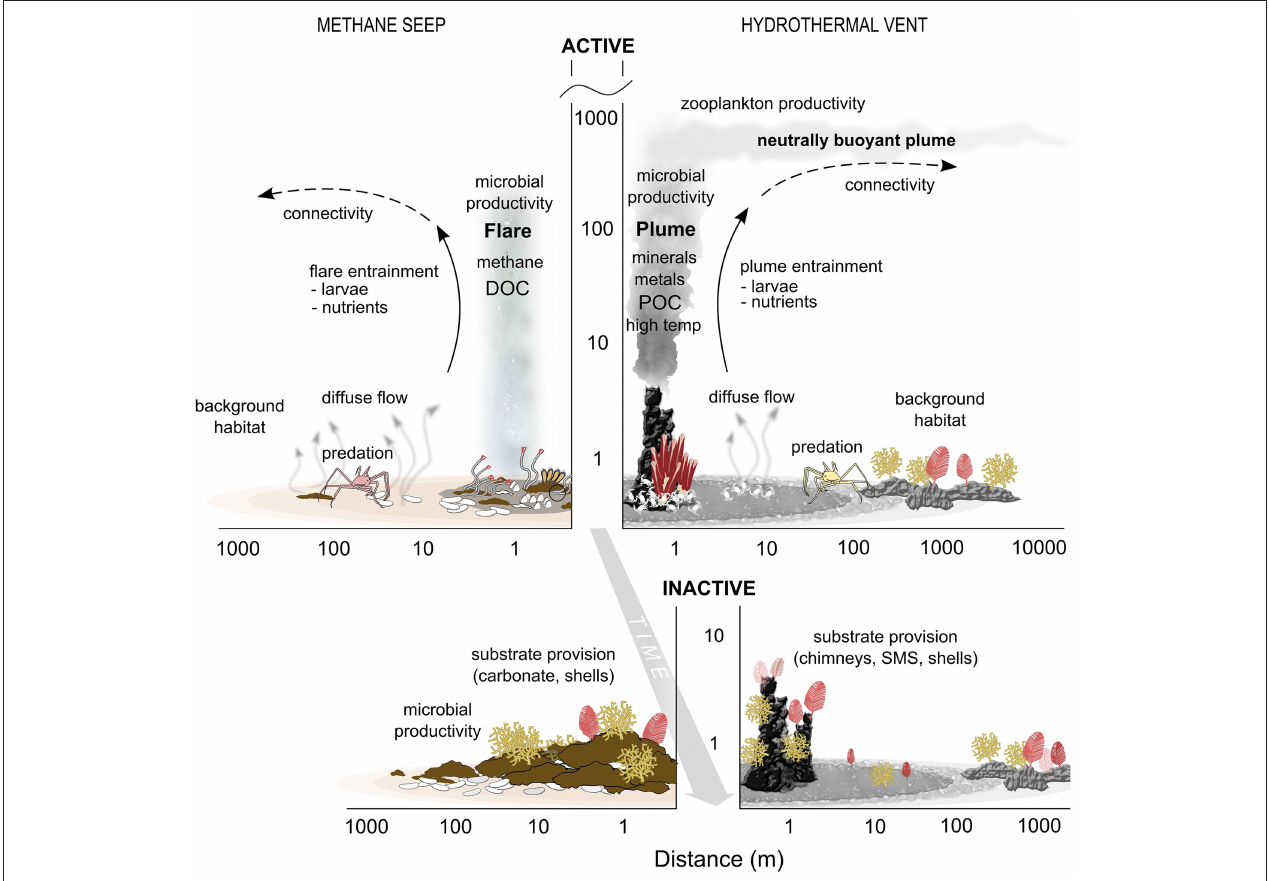
FIGURE 3 | Schematic of seep and vent interactions with surrounding deep-sea ecosystems. The y axis is meters above bottom on a log scale. DOC, Dissolved Organic Carbon; POC, Particulate Organic Carbon; SMS, Seafloor Massive